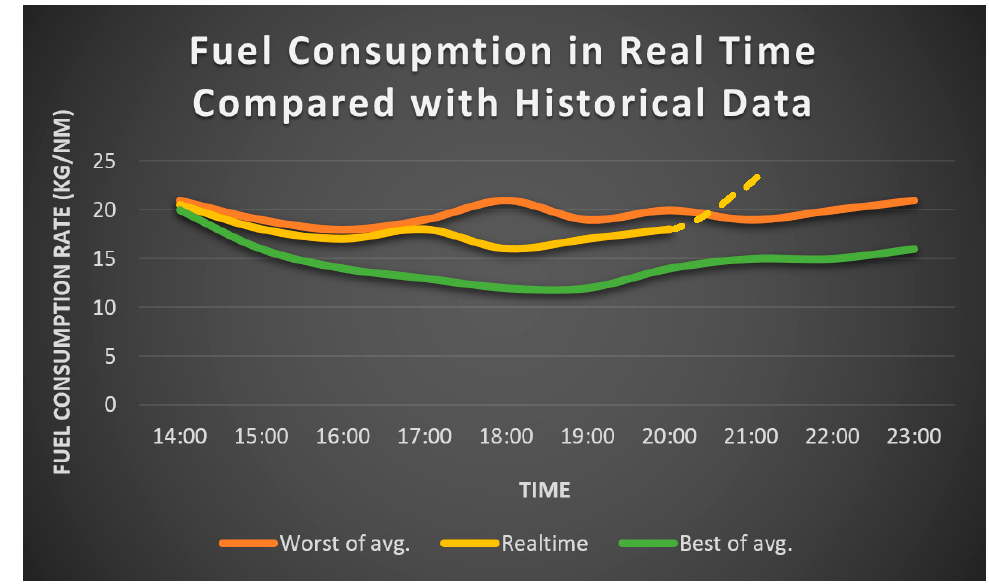
Figure 12. Fuel consumption in real time compared with historical consumption curves.